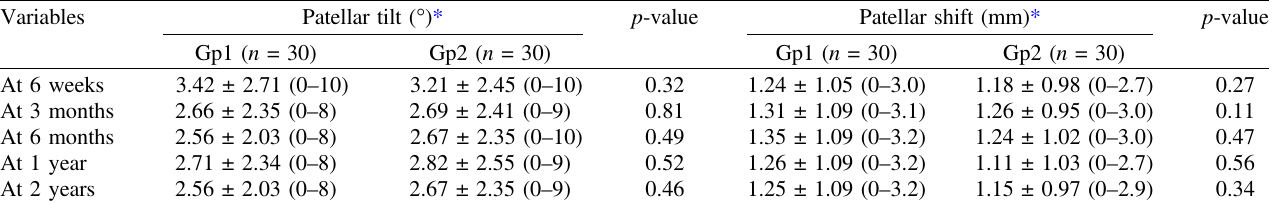
Table 3. Patellar tilt and patellar shift.